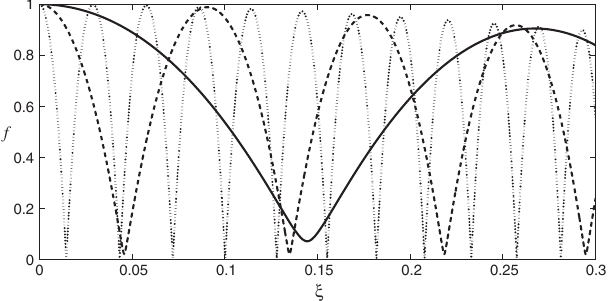
FIG. 3. Dependence of the beamwidth parameter on the dimen- sionless propagation distance and in conditions of Fig. 1 for different initial plasma densities of n 0 ¼ 4 × 10 19 cm − 3 (dashed) and n n 0 e with B ¼ 2 .